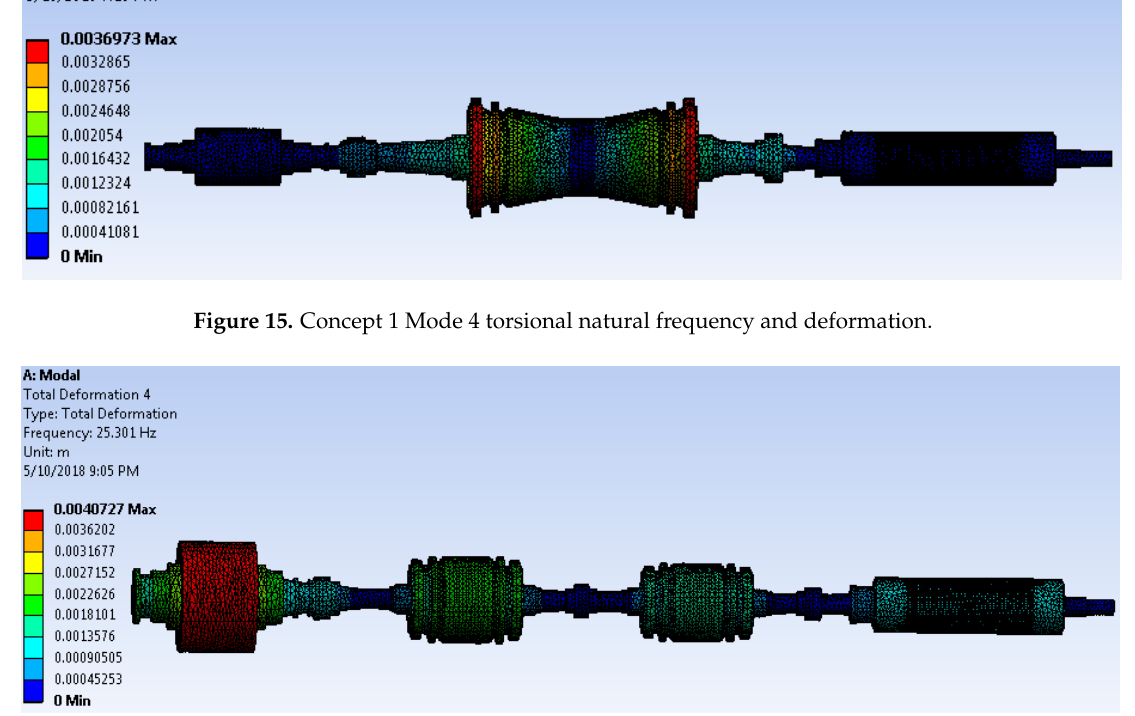
Figure 16. Concept 2 Mode 4 torsional natural frequency and deformation.